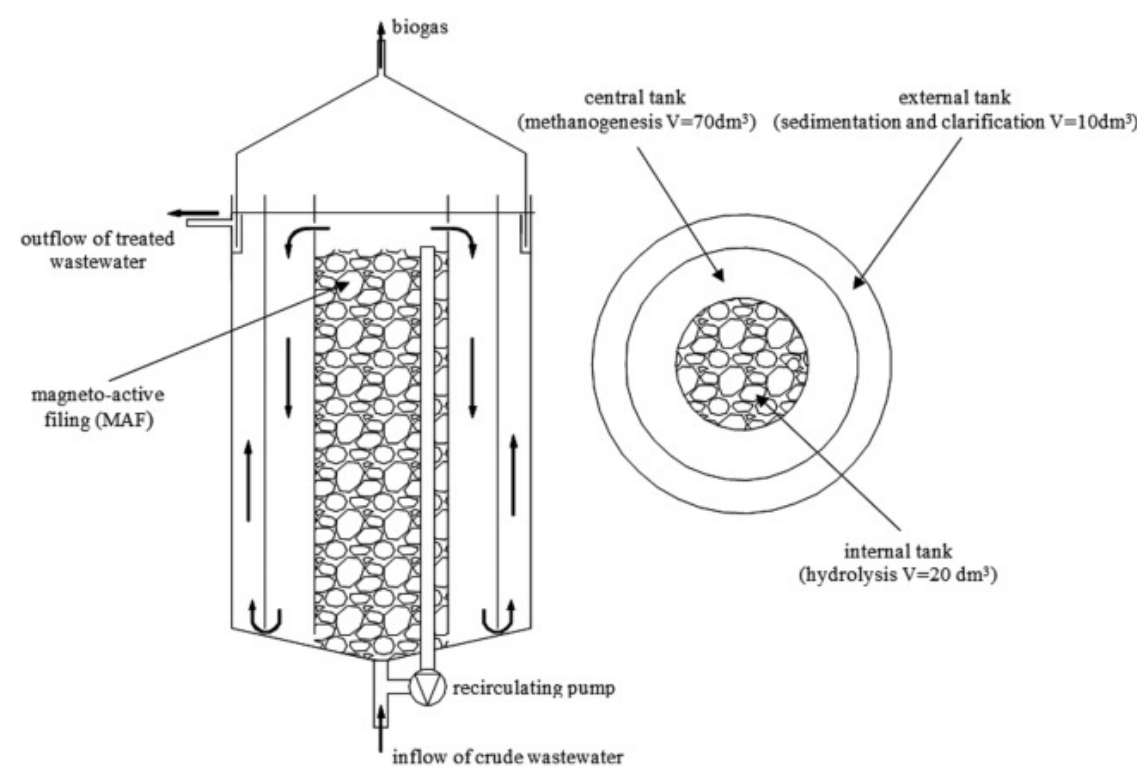
Figure 13. Labyrinth ‐ flow vertical anaerobic reactor (LFAR).